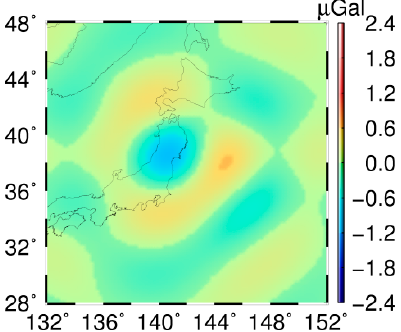
Figure 5. Gravity changes on a sphere with a height of 260 km computed by the tailored spherical harmonic coefficients from the forward model with a Gaussian filter applied. The SH degree range is 30–95 and the radius of the filter is 210 km. The unit is μ Gal.